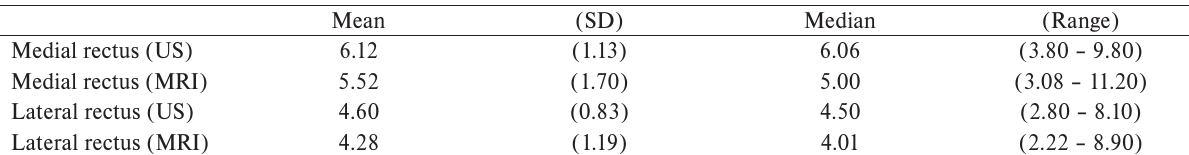
Table 1. Eye muscle thickness values obtained by ultrasonic measurement (US) and measurement on MRI scans, all given in mm.